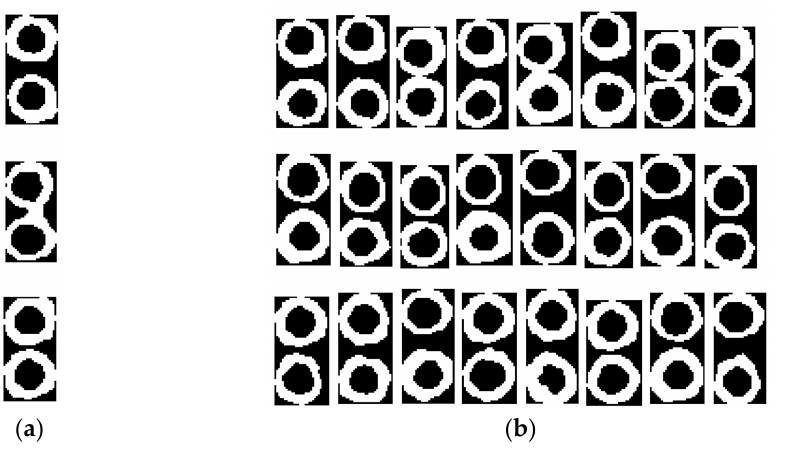
Figure 8. Example of character samples before and after augmentation: ( a ) character sample before augmentation; ( b ) character sample after augmentation.